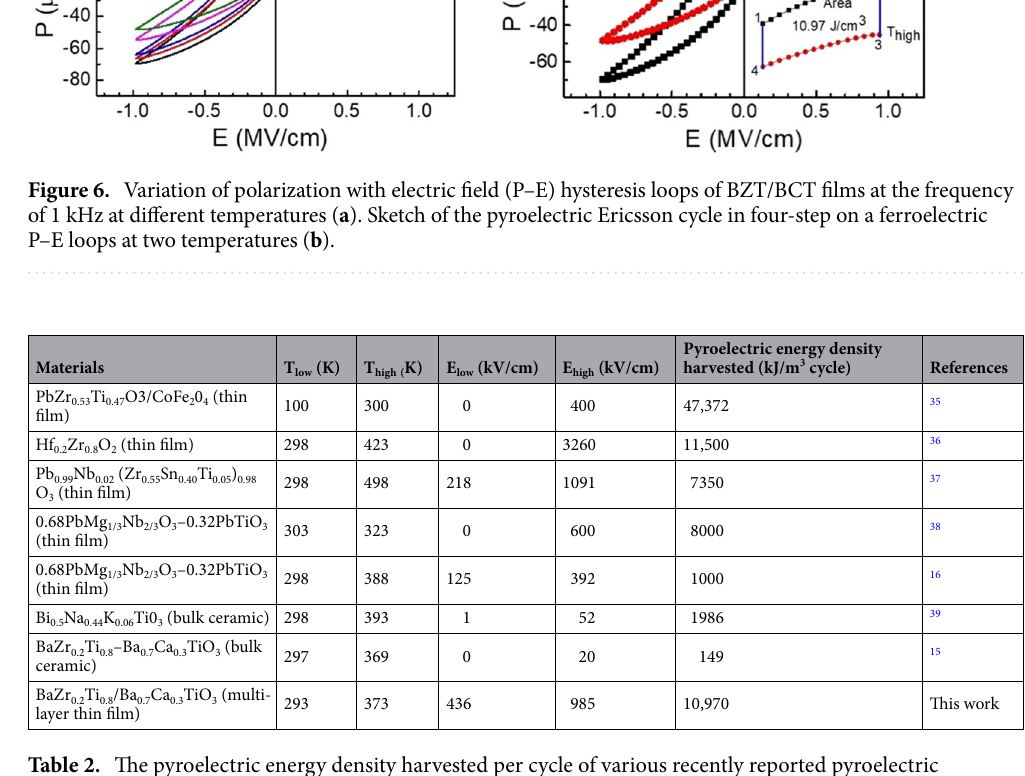
Table 2. The pyroelectric energy density harvested per cycle of various recently reported pyroelectric materials.